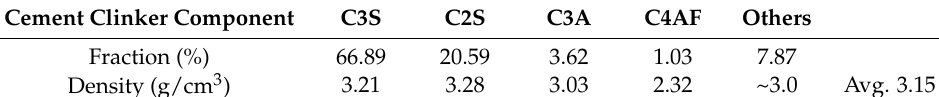
Table 1. Mineral composition of the white cement [12].